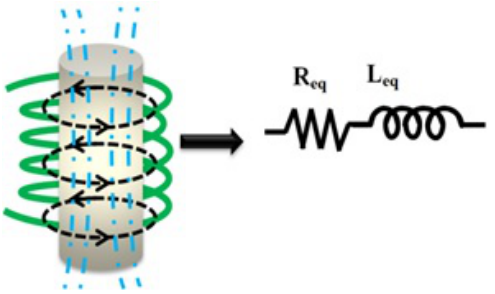
Figure 3. Typical equivalent model of IH